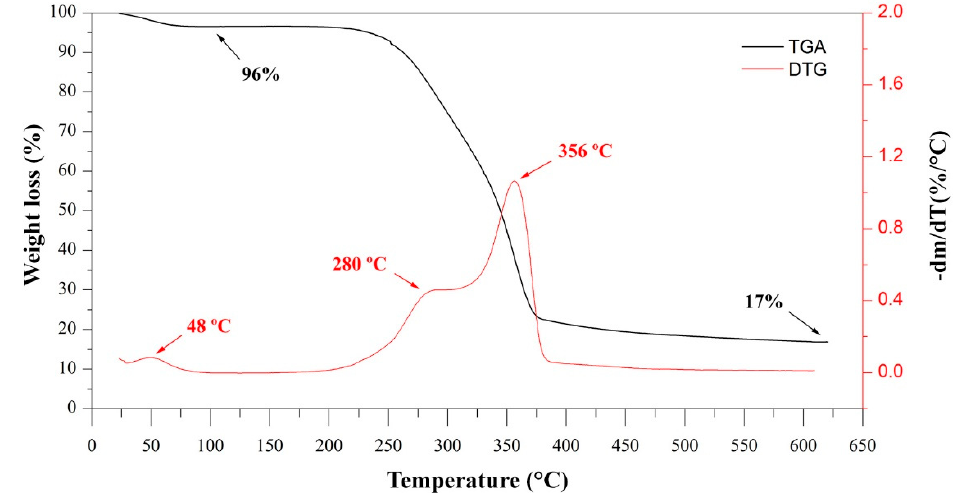
Figure 9. TGA and DTG curves for the Buriti foam.